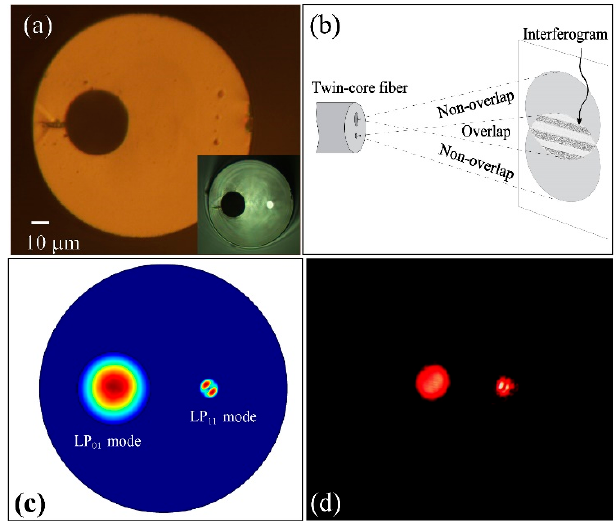
Figure 1. ( a ) Cross section of the DCF. In the insert, the solid core of the DCF is lit up. ( b ) Schematic of the sensing scheme. Output light from the two cores partially overlap and produce interferometric fringes in the overlapped region. ( c ) Guided mode simulated using finite element method (COMSOL 5.0). In the hollow core and the solid core, we plot the field distribution of the LP 01 mode and the LP 11 mode, respectively. ( d ) Guided modes experimentally visualized by a CMOS camera.